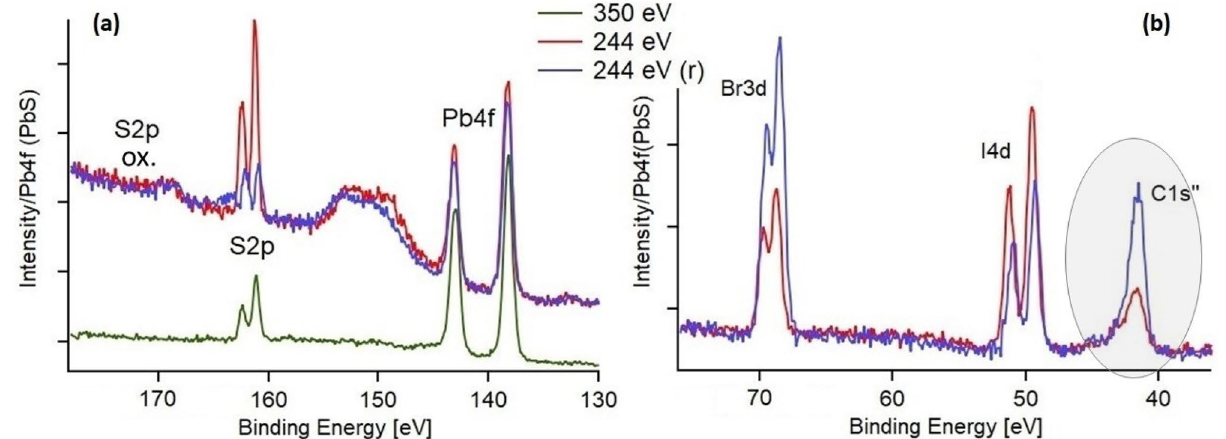
Figure 3. Steady state PES spectra of 250 nm thick PbS quantum dot sample at 244 and 350 eV photon energy. 244 eV (r) shows a measurement of a sample which had been exposed to ambient atmosphere for several days. ( a ) Pb 4f and S2p region. The wide peak at 150 eV is an Auger peak from Pb. ( b ) I 4d and Br 3d region. The C 1 s peak observed originates from the 2nd order of light refracted from the monochromator (488